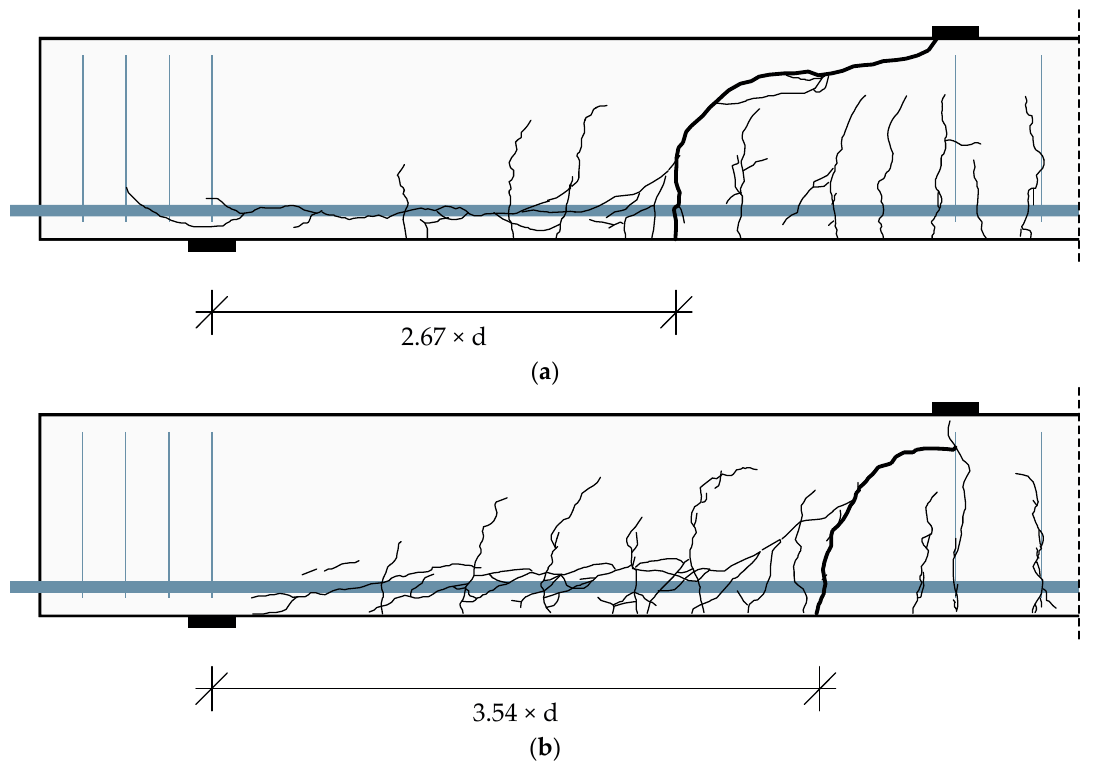
Figure 5. Experimental crack pattern at the state of failure: ( a ) B1-1 with V u,a = 104.8 kN and ( b ) B1-2 V u,a = 105.1 kN. Table 2. Ultimate load F u and resulting shear force at the support V u (self-weight neglected). Test No.